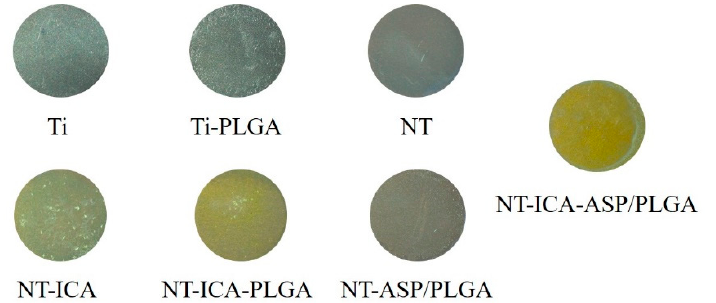
Figure 1. Macro surface morphology of various surfaces was observed under stereomicroscope (S9i; Leica Microsystem, Tokyo, Japan) and representative images were shown (10 ×).